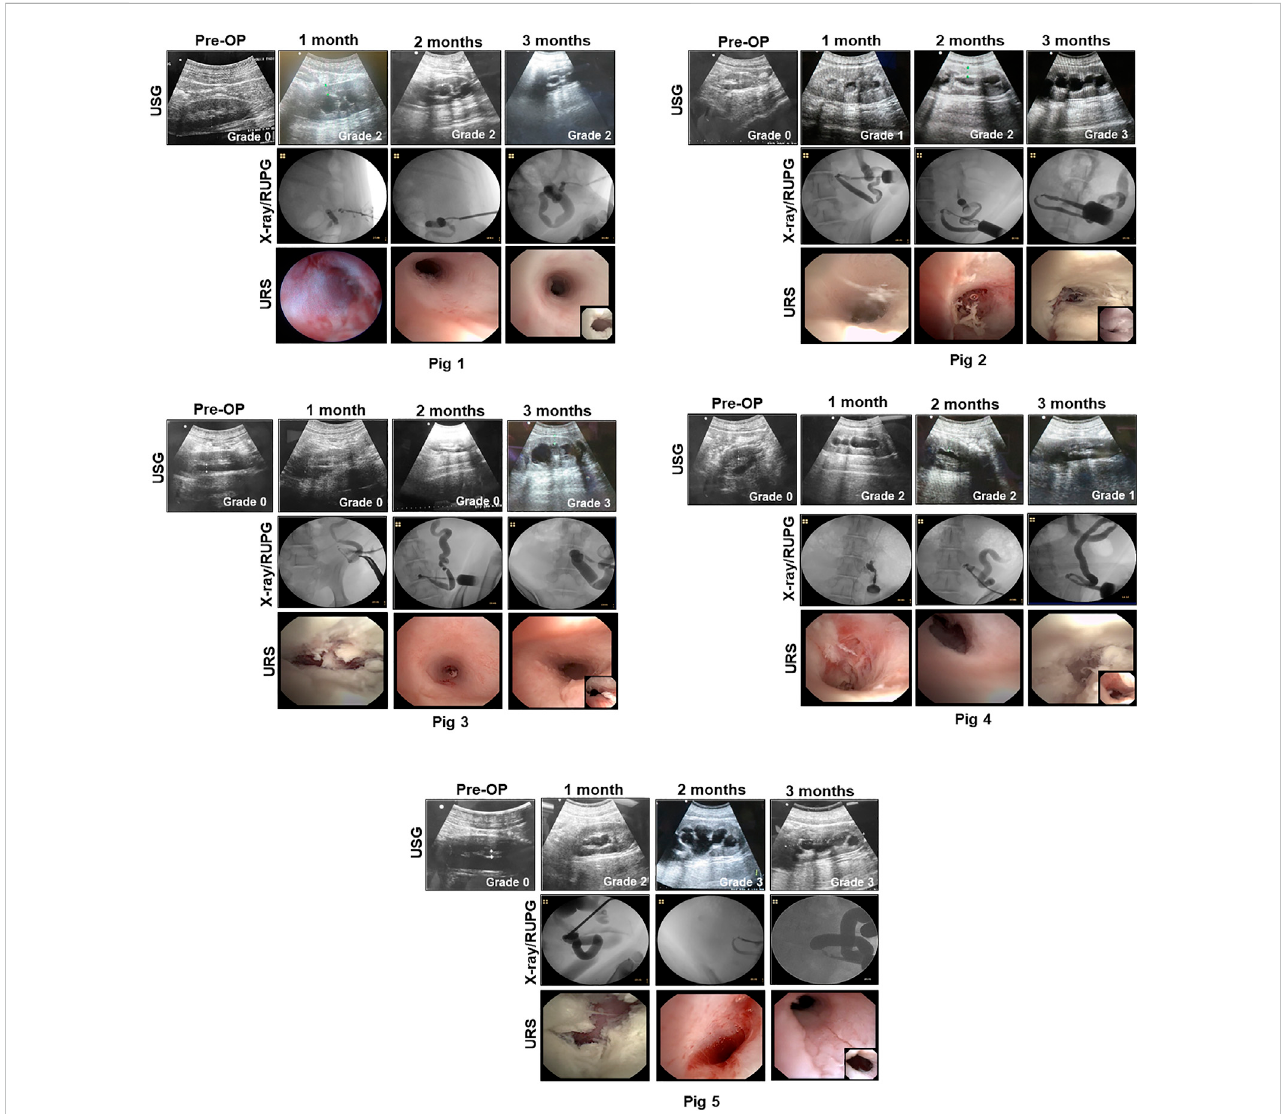
FIGURE 2 Imaging evaluations of neoconduits and upper urinary tract in reconstructed animals. Representative data for Pigs 1 – 5. USG (top row with hydronephrosis scores), X-ray/RUPG (second row), and URS evaluations of central neoconduits (bottom row, insets showing proximal ureteral anastomosis) were performed at various experimental timepoints. USG, ultrasonography, retrograde ureteropyelogram (RUPG), and uretero-renoscope